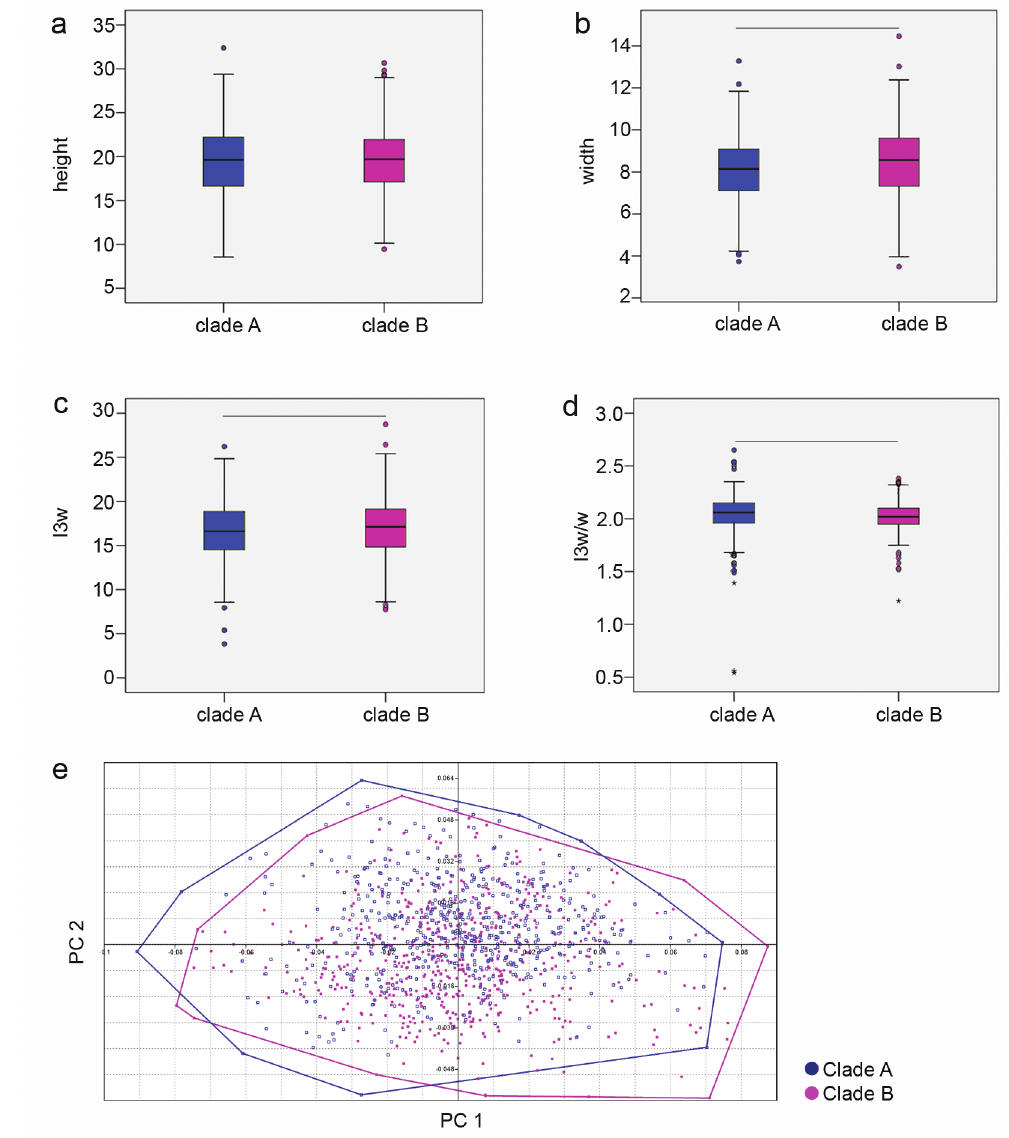
Figure 7. Results of biometric ( a–d ) and geometric morphometrics study ( e ), for the two mitochondiral clades of Tarebia granifera (Lamarck, 1816) found in this study. Boxplots of ( a ) shell height, ( b ) shell width, ( c ) height of the last three whorls and ( d ) index of height of last three whorls agaianst shell width. Significant differences between groups are indicated by bars above the boxplots ( e ). Relative variance in shell shape along PC1 and PC2. Colour corresponding planes indicate the spread of each morph in the data